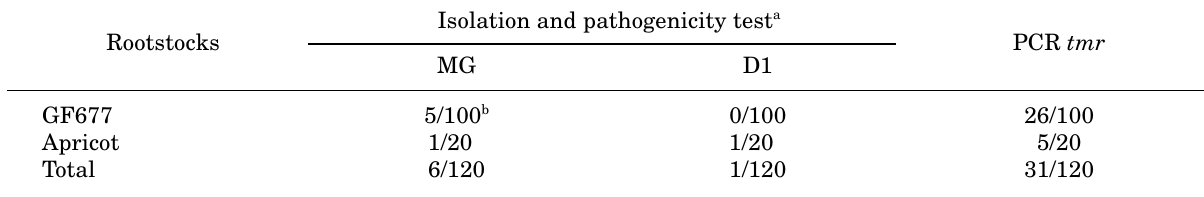
Table 3. Detection of Agrobacterium biovars from symptomless plants by isolation on selective media and detection with PCR tmr